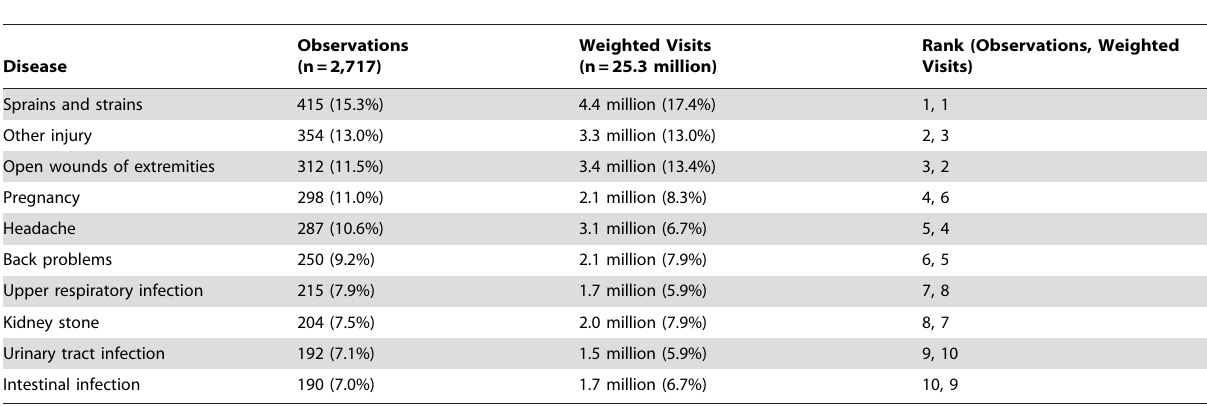
Table 2. Ten most frequent treat and release ED Diagnoses, 2006–2008.